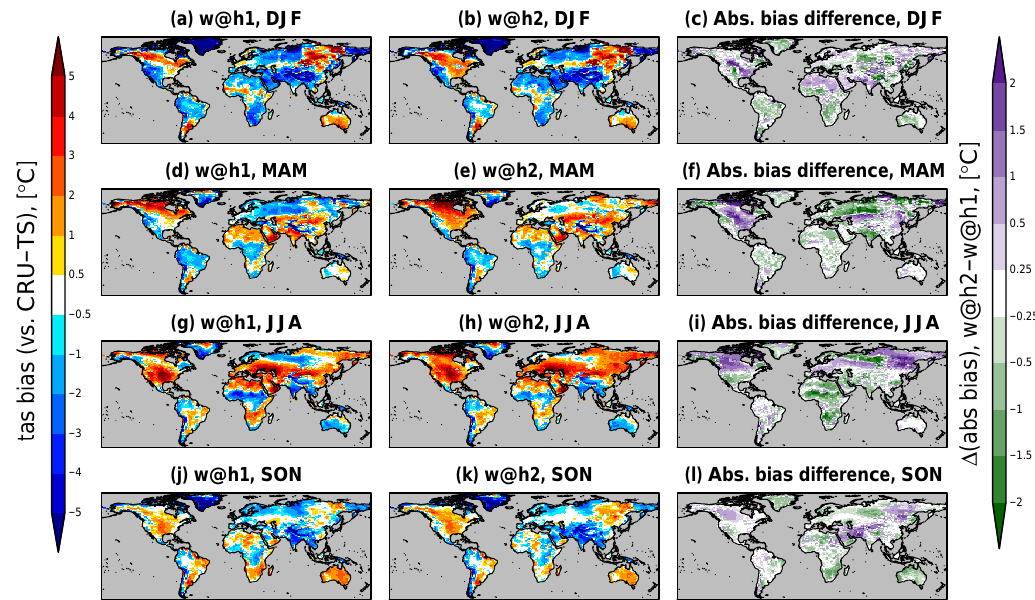
Figure 2. Biases in surface air temperature for the GCM HadAM3P in w@h1 (left; a, d, g, j ) and w@h2 (middle; b, e, h, k ), and the difference in absolute biases (right; c, f, i, l , expressed as w@h2 minus w@h1, i.e. negative values indicate an improvement). Each row corresponds to a season (from top to bottom: DJF, MAM, JJA, SON). Biases are computed with respect to the CRU-TS dataset and are expressed in ◦ C, and grey indicates regions without data (ocean grid cells).